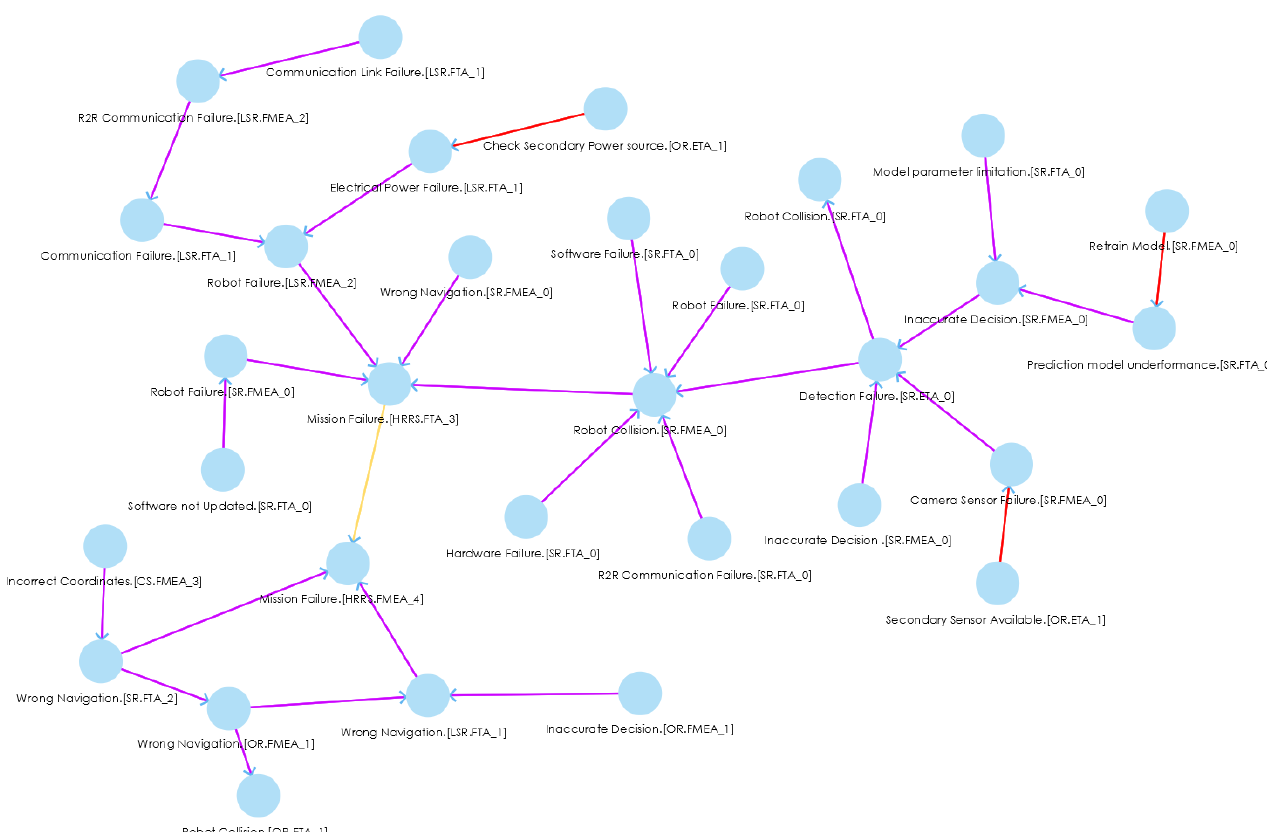
Figure 6. An excerpt of FPG for HRRS.